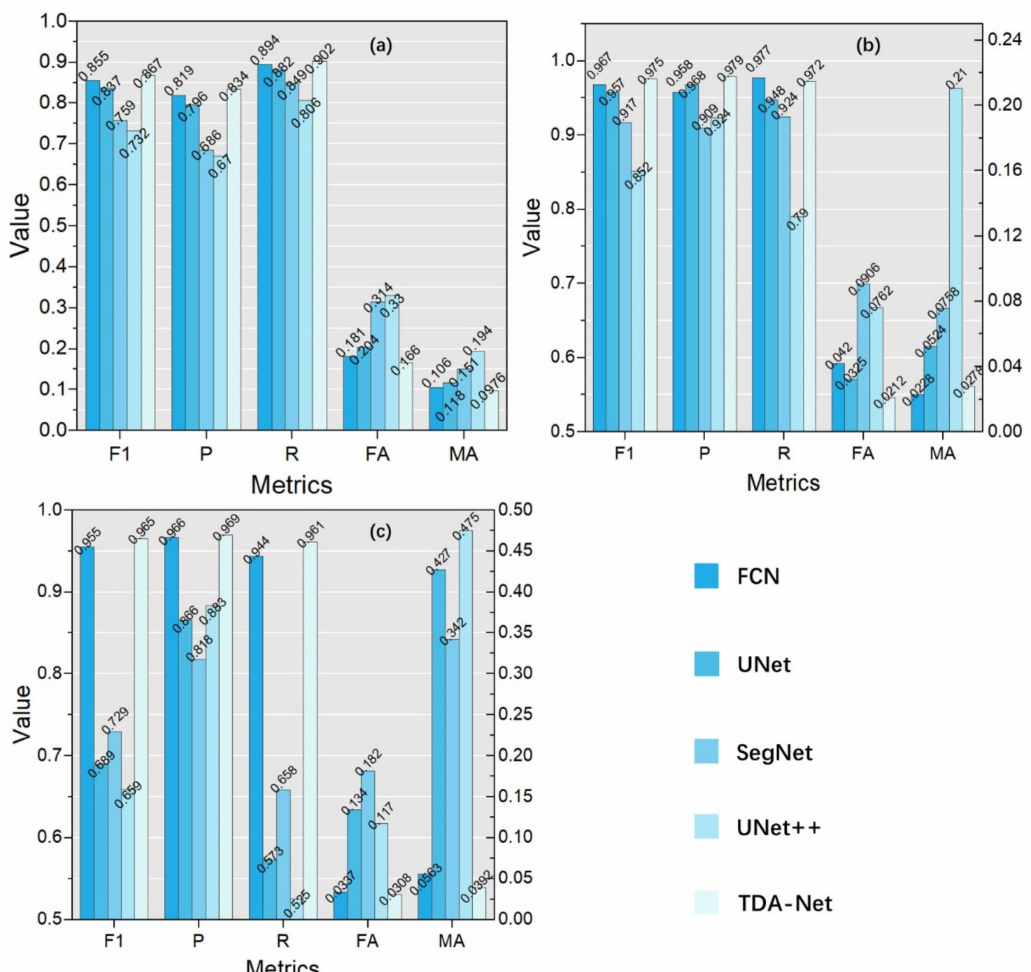
Figure 9. Visualization of metrics for prediction results. ( a ) WHU Building, ( b ) Beirut, and ( c ) Tianjin